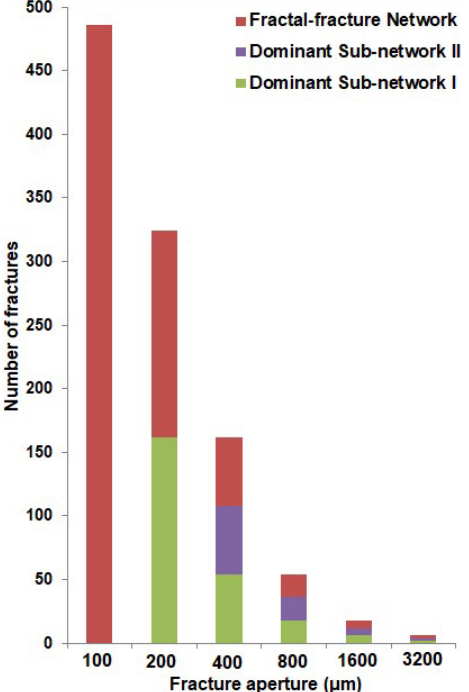
Figure 2. Number of fracture segments vs. aperture for a fractal- fracture network and its dominant sub-networks-I and -II.